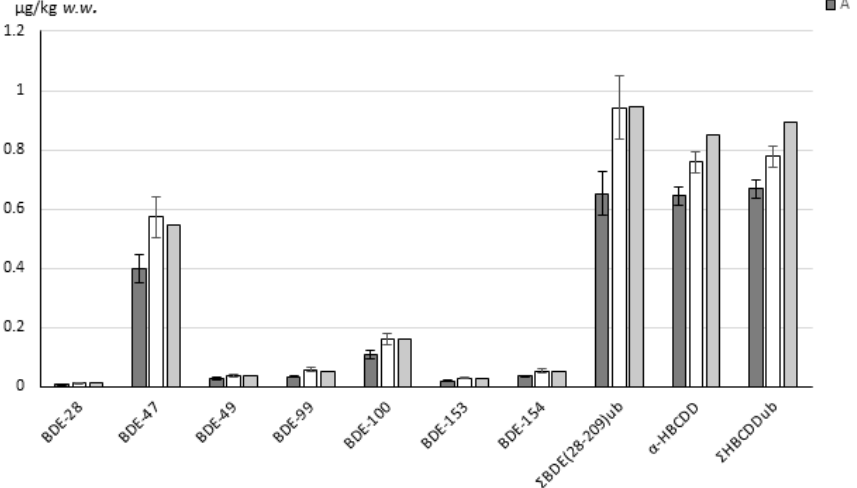
Comparison of the results for PT sample fish fillet, obtained with UAE and two different amounts of Na 2 SO 4 with the assigned values: A: drying with 20 g Na 2 SO 4 , 60 mL dichloromethane:hexane (1:1, v/v ), UAE; B: drying with 40 g Na 2 SO 4 , 60 mL dichloromethane:hexane (1:1, v/v ), UAE; C: assigned values.